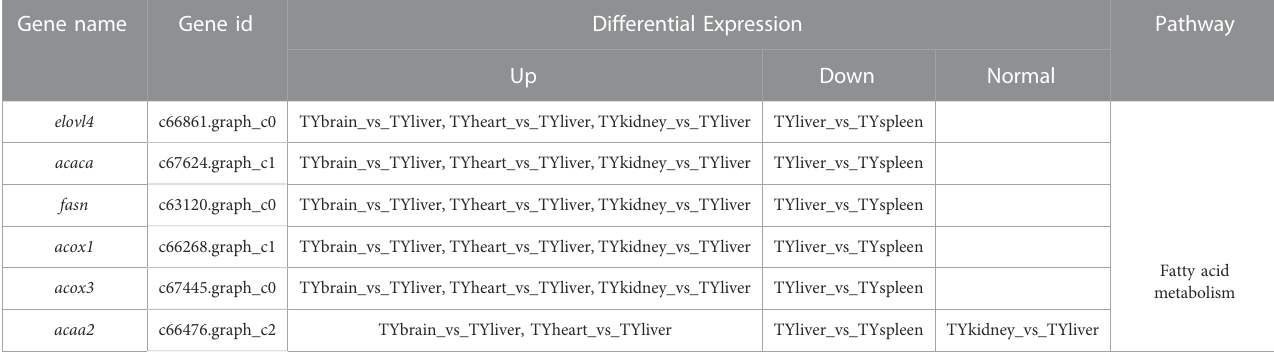
TABLE 2 Differential expression in tissues of six genes involved in fatty acid